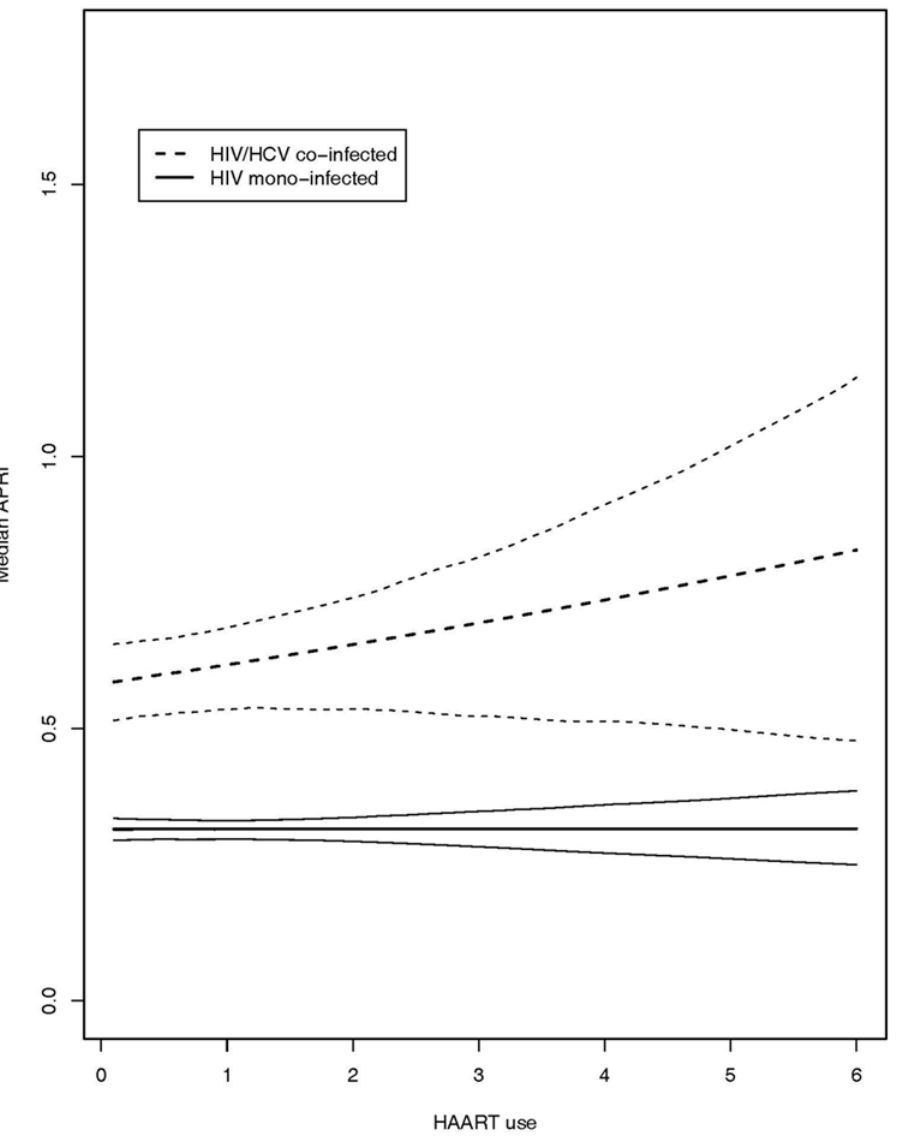
Figure 3. Estimated dose-response function: change in APRI due to HAART intake between clinical visits. The plot includes point-wise 95% confidence bands for HIV mono-infected patients (solid line) and HIV/HCV co-infected patients (dashed